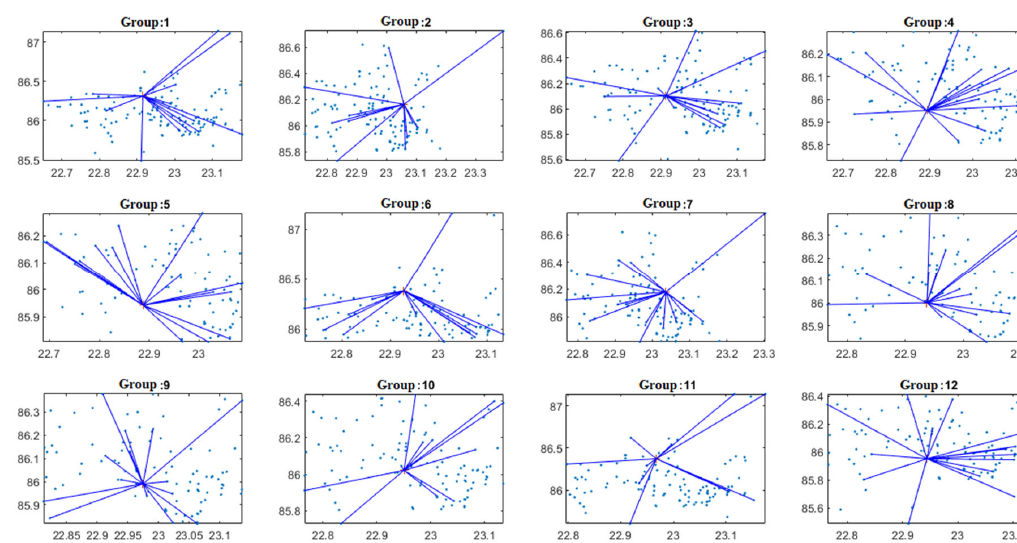
Fig. 6. Assignment of the children to groups